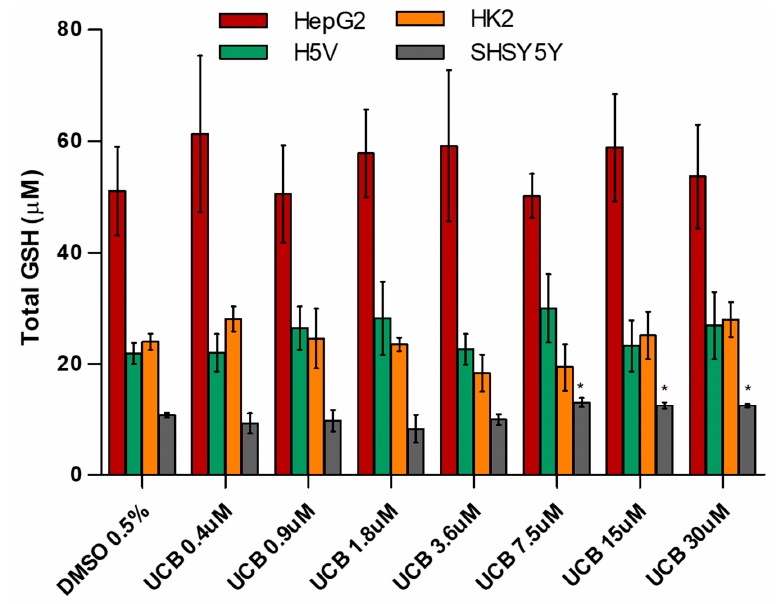
Figure 5. The effect of UCB exposure on intracellular glutathione (GSH) concentrations. The cell lines were exposed to increasing UCB concentrations (from 0.4 to 30 µM in the presence of 30 µM BSA) or 0.5% DMSO for 24 h and then total GSH concentration was measured. Data are expressed as mean ± SD of three independent experiments. * p < 0.05. The basal level of GSH was higher in HepG2 cells. GSH concentration was not affected by UCB